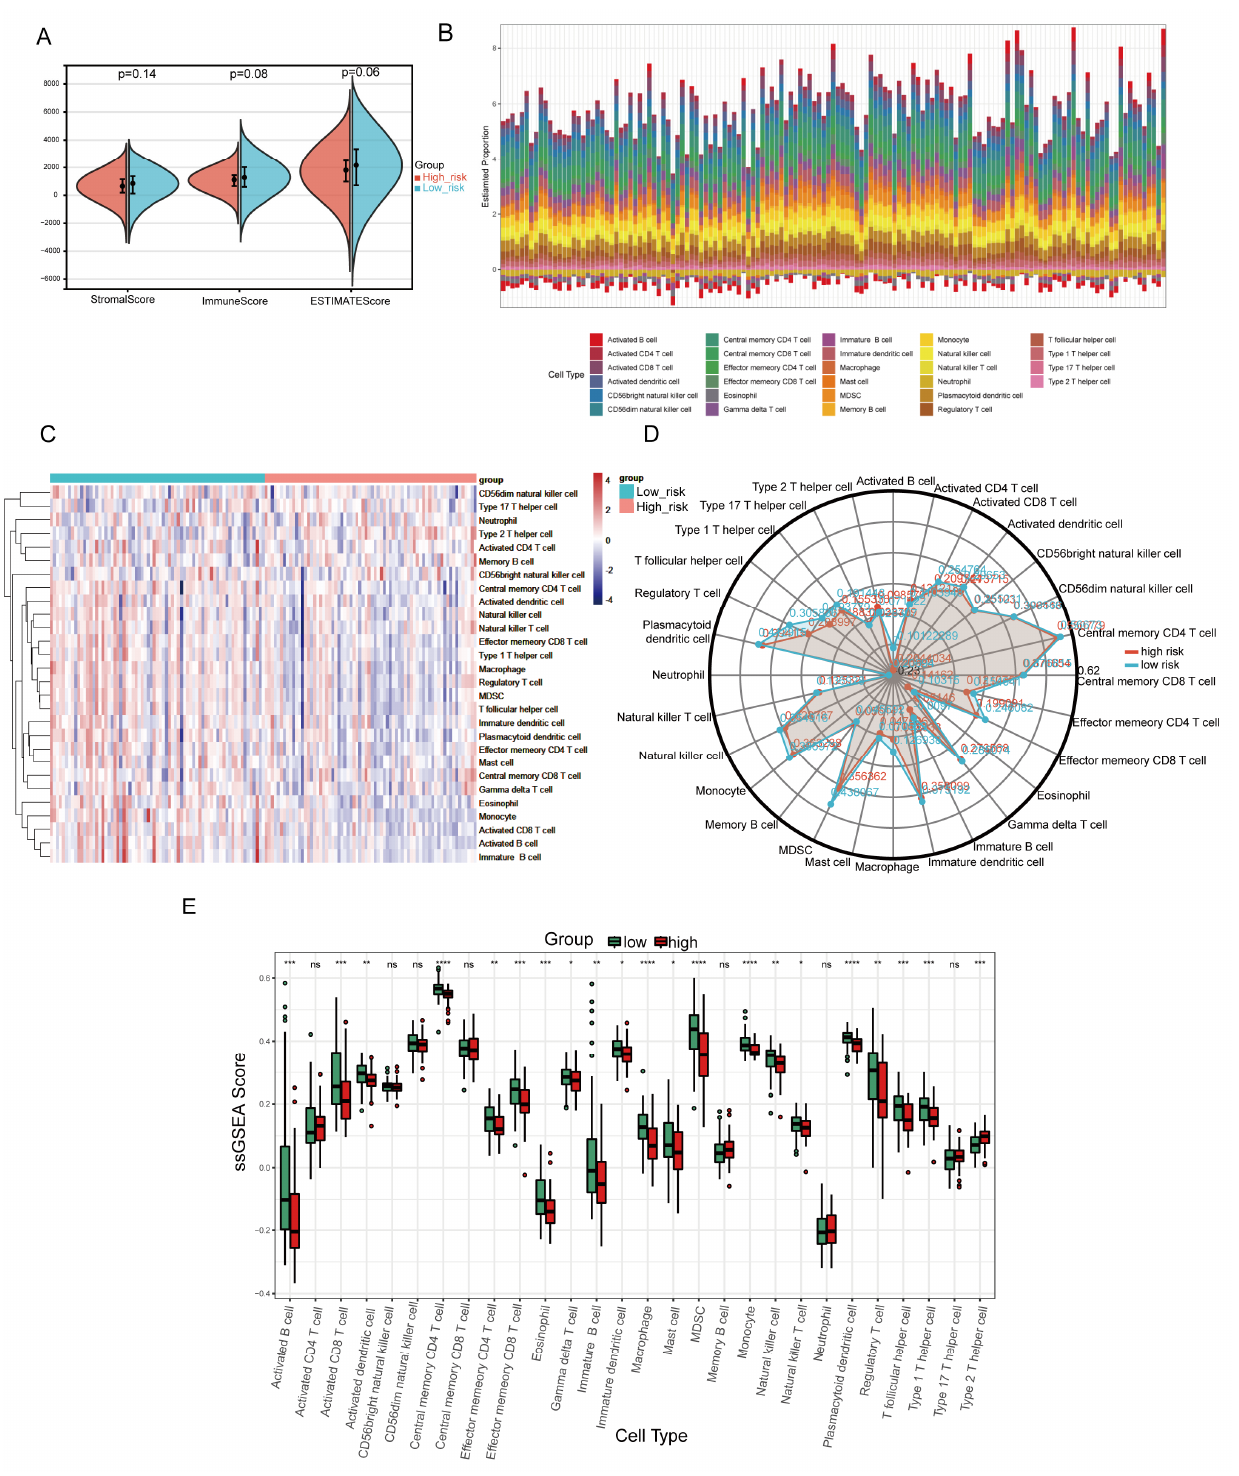
Figure 7. The analysis of tumor immune microenvironment between high-risk group and low-risk group. ( A ) The comparison of stromal score, immune score, and ESTIMATE score between the high- and low-risk groups. ( B ) A column stacking diagram exhibiting an overview proportion of different type of immune cell in TCGA cohort. ( C , D ) The heatmap and radar chart showing the difference in distribution of various immune cells between high- and low-risk groups. ( E ) The analysis of 28 immune infiltrated cells between the high- and low-risk groups. **** p < 0.0001, *** p < 0.001, ** p < 0.01, * p < 0.05. “ns” stands for no significant difference between the values from the two groups.